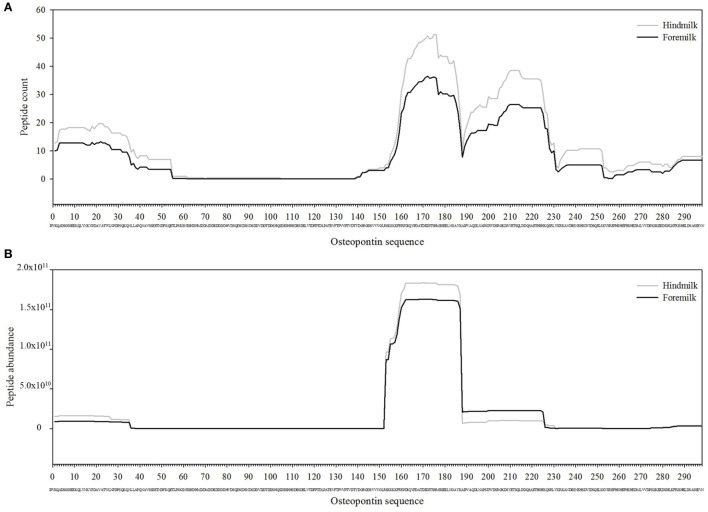
Count (A) and abundance (B) of peptides identified in breast milk mapped on the sequence of osteopontin.